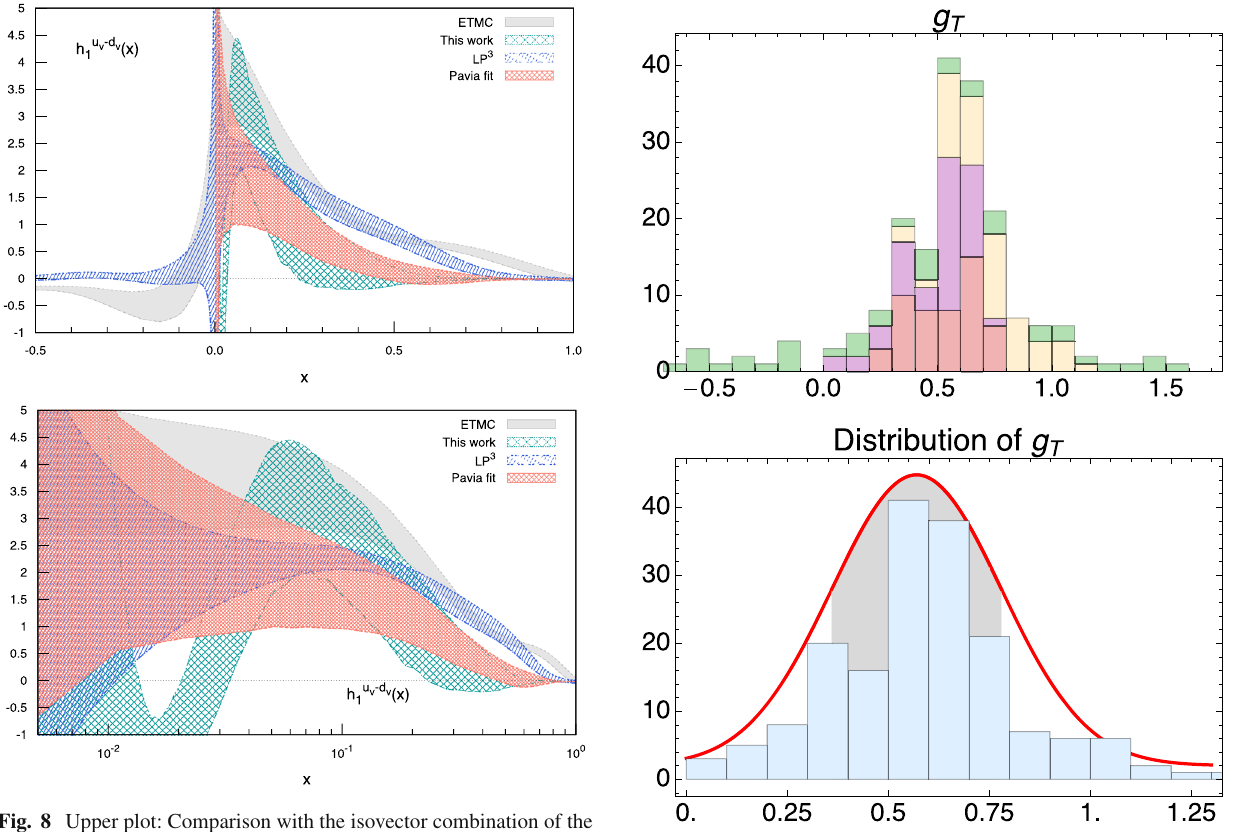
Fig. 9 Stacked histogram of isovector tensor charge. The color code represent, as above, the four different degrees of the Bernstein poly- nomial of the functional form, respectively, n = 10 , 20 , 30 , 40 in red, purple, yellow and green. Notice that the various contributions are rep- resented on a single bar, i.e. stacked. On the lower panel, we can see that g T is gaussianly distributed, as shown in red with the corresponding 1 σ error in gray tensor charge – the latest results are g T = 0 . 926 ( 32 ) for the ETM Collaboration [23], g T = 0 . 972 ( 41 ) [24]